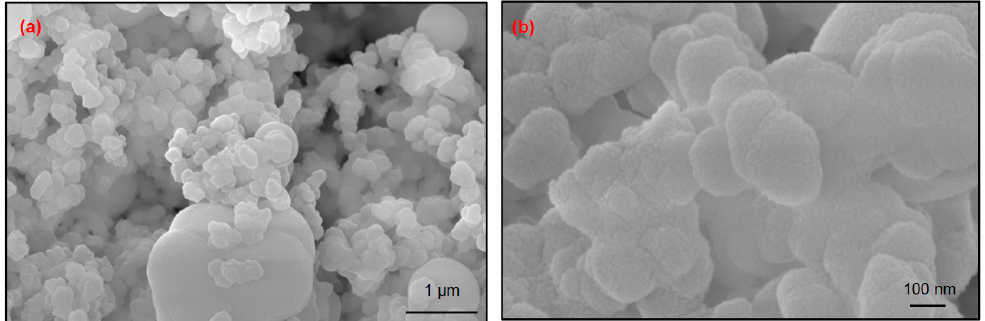
Figure 3. Field emission-scanning electron microscopy (FE-SEM) images ( a ) high- and ( b ) low-scale magnification image of a synthesized Co 3 (PO 4 ) 2 nanosphere sample.